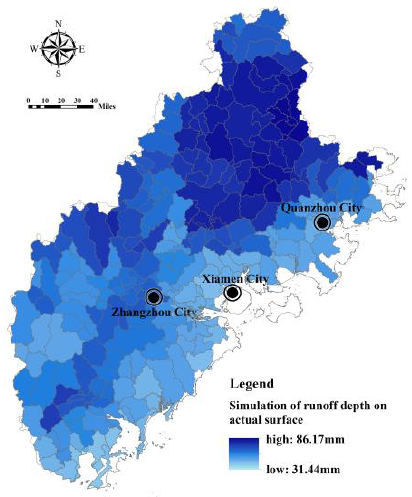
Figure 6. Simulation of actual surface runoff in Fujian Delta.